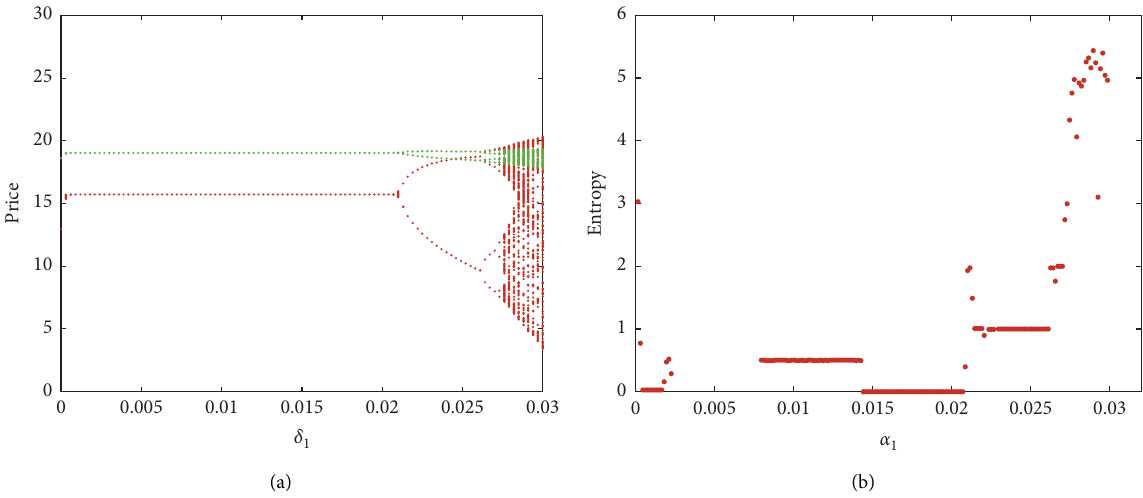
Figure 9: The price bifurcation and entropy with δ